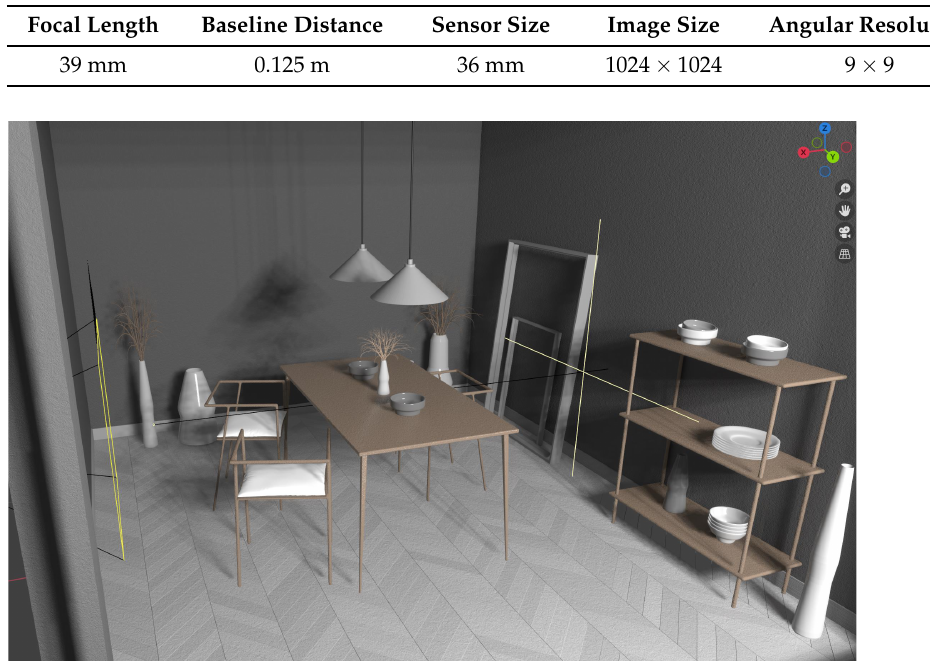
Figure 1. The Blender interface used to generate light field